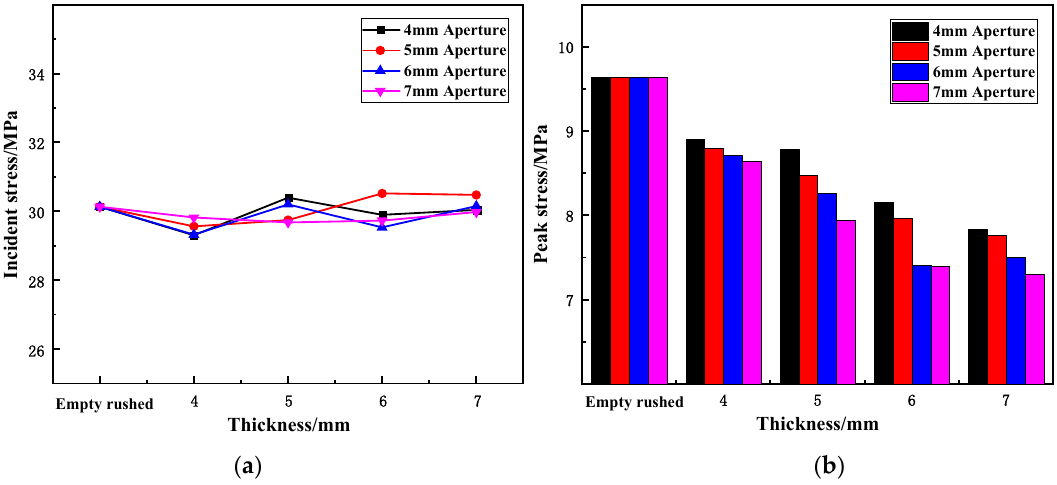
Figure 11. Variation trend of incident and reflected stresses of wave-absorbing metal plate with thick- ness. ( a ) Variation in incident stress with thickness; ( b ) Variation trend of peak stress with